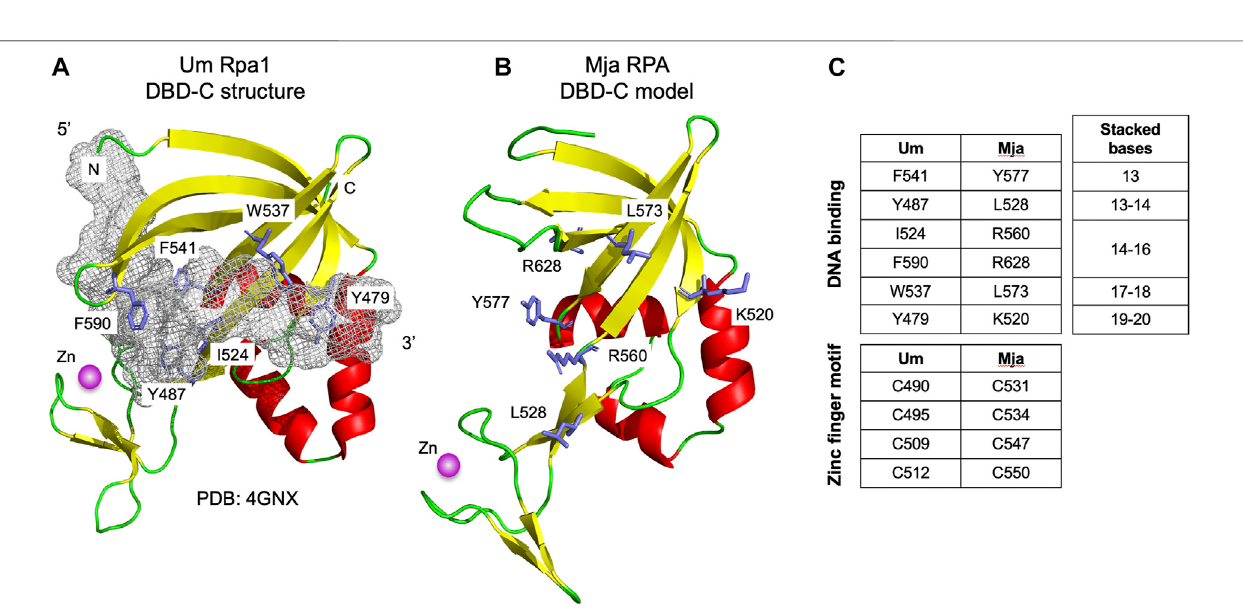
Frontiers in Molecular Biosciences |